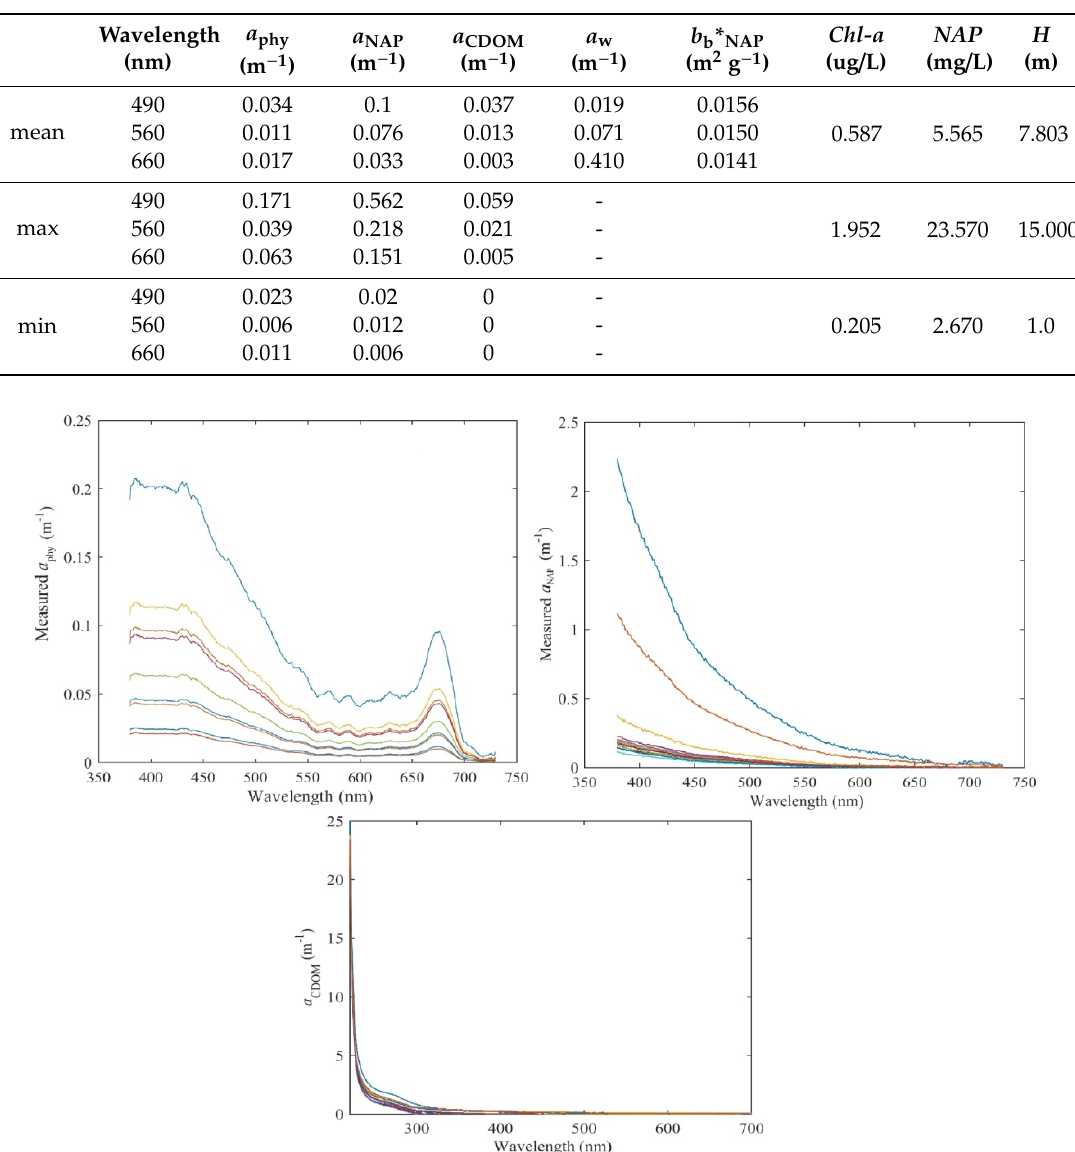
Table 1. The measured water column parameters for the model input include the absorption coefficients, the water constituent concentrations, and the water depths. NAP, non-algal particle.